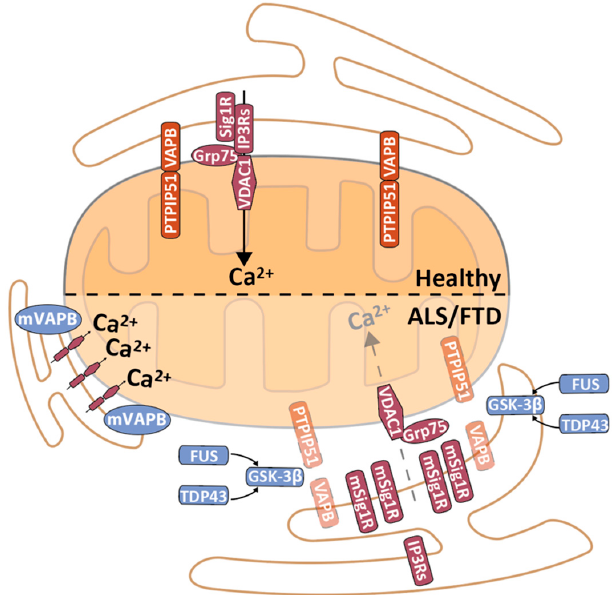
Figure 3. MERCS in health and in ALS/FTD. In healthy controls (upper part of the figure), different functions of MERCS are integrated to maintain cell homeostasis. Complex IP3Rs-Grp75-VDAC1 and VAPB-PTPIP51 modulate the ultrastructure of MERCS. In ALS/FTD, FUS and TDP43 activate GSK-3 β , which dissociates PTPIP51 and VAPB and decreases the connectivity between the ER and mito- chondria. Mutation in Sigma-1R (mSig1R) leads to the accumulation of these proteins at MERCS and to mislocalization of IP3R outside MERCS, leading to a juvenile form of ALS. Mutation in VAPB (mVAPB) leads to an increase in MERCS and an increase in the flow of Ca 2+ inside mitochondria. Different colours correspond to proteins involved in different cellular processes and faded colours as well as dashed lines represent the downregulation of the process or protein level/function. 6. MERCS as a Drug Target Taken together, the data presented above suggest that even though AD, PD, ALS and FTD are four distinctive diseases, alterations of MERCS are common features observed in all of them. Therefore, one can question whether chemical modulation of these MERCS can be used to prevent neurodegeneration and halt the progression of these pathologies. The value of MERCS as drug targets becomes more evident because several clinical mon- otherapy trials for these pathologies have failed. Therefore, researchers are starting to change their strategies and drop the “one target, one treatment” approach and try to tackle different aspects altered in these pathologies. However, due to the complexity, organiza- tion and dynamics of MERCS, finding a drug that allows their modulation and, particu- larly, a single function/type of contacts might be extremely challenging. Thus, structural system pharmacology, which combines large-scale experimental studies with computa- tional modelling, has been suggested as a possible method to develop efficient drugs to modulate MERCS [37]. In agreement with Magalhães Rebelo and colleagues, we believed that drugs can affect MERCS mainly via three different pathways: by direct interaction with proteins in MERCS, by affecting protein expression levels or by modulating up- stream signalling pathways that result in the alteration of the ultrastructure and/or func- tion of MERCS [37]. Currently, there are several drugs available that affect proteins asso- ciated with MERCS. However, in most cases, MERCS were not assessed when these drugs were developed, and most of these drugs were discovered in cancer settings. Some exam- ples are as follows: VDAC1—Drugs that affect the channel conductance (e.g., König’s polyanion, dicy- clohexylcarbodiimide, fluoxetine, aspirin and itraconazole), its interaction with its partner